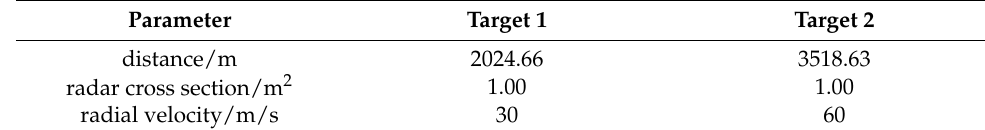
Table 3. Movement target parameters.